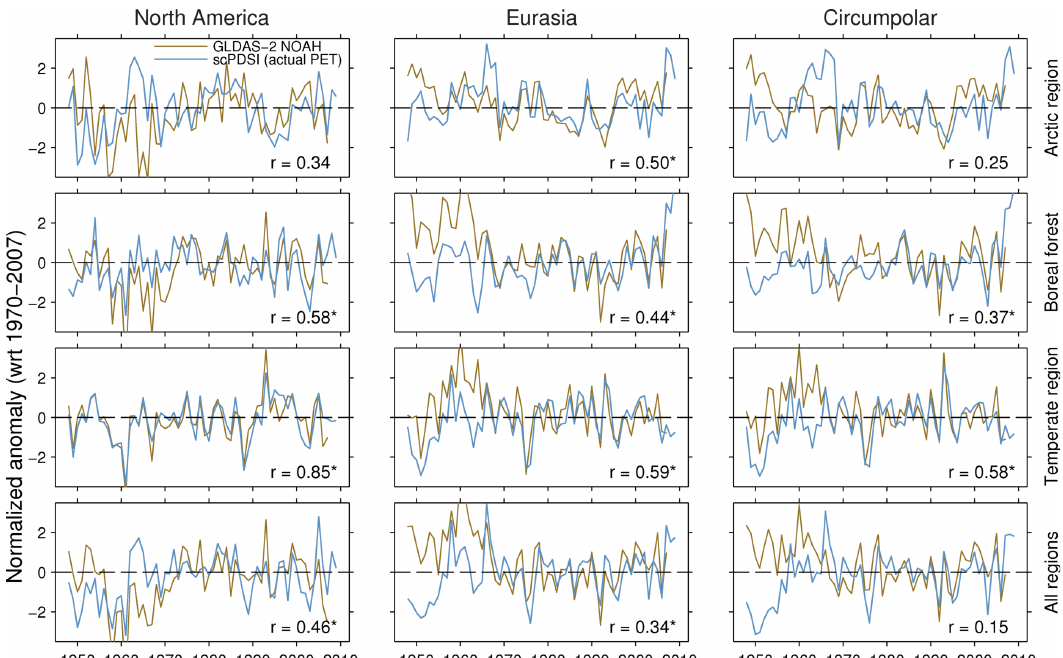
Figure A4. Comparison of average summer scPDSI (blue) and summer 10-cm soil moisture simulated by GLDAS-2 Noah (brown) over the period 1948–2008 for each region and continent. Correlations over the full overlapping period are indicated in each panel (*: p < 0.1). Note the good agreement since around